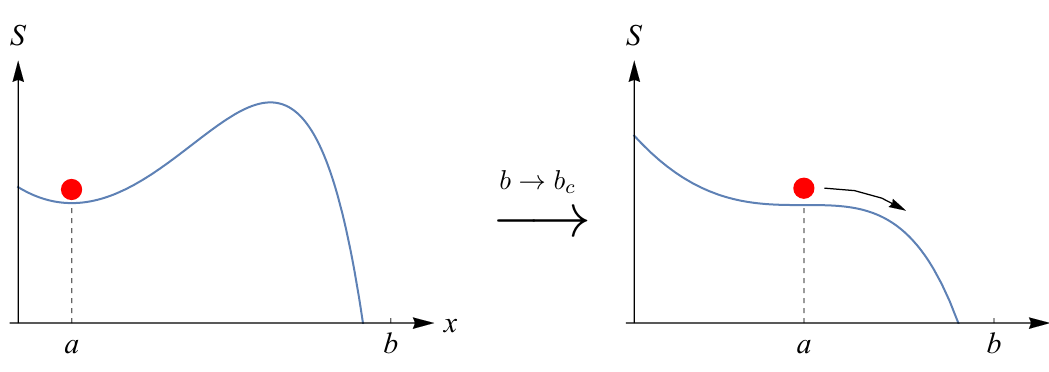
q r − r h . If the r h